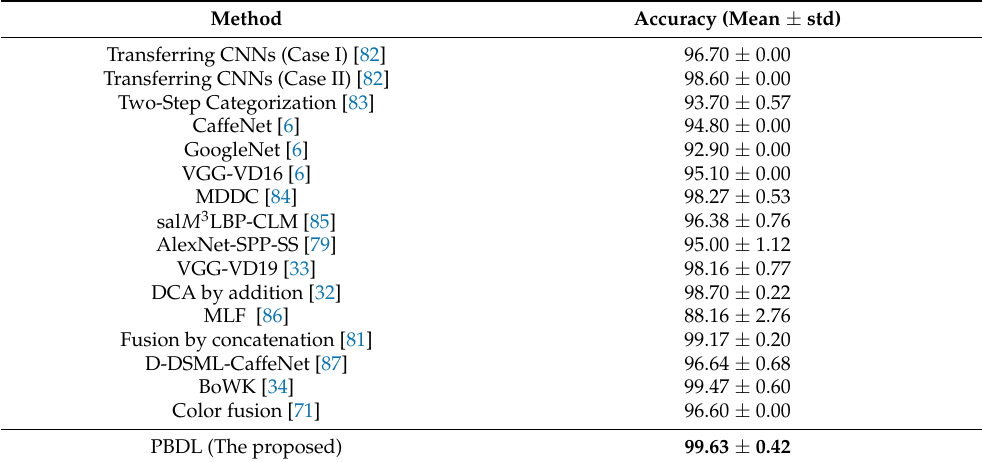
Table 8. Comparison of classification accuracy (%) for the WHU-RS19 with 80% ratios. The results are obtained directly from the corresponding